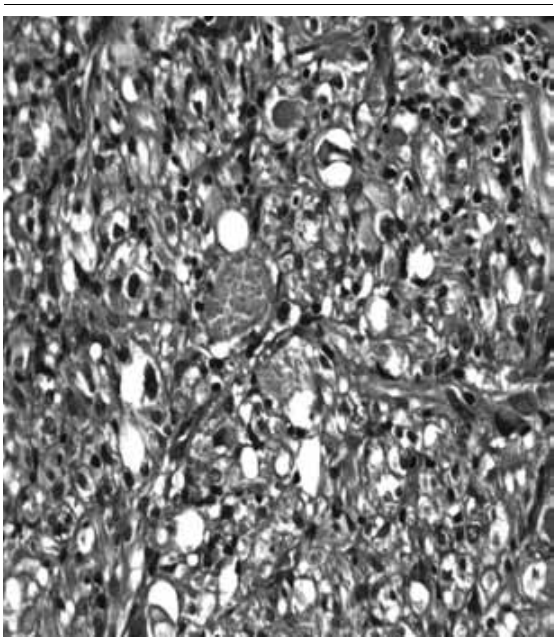
figurE 5 – Eosinophilic granular body in pleomorphic xanthoastrocytoma in the center of the image (HE, lens 40×) HE: hematoxylin and eosin.